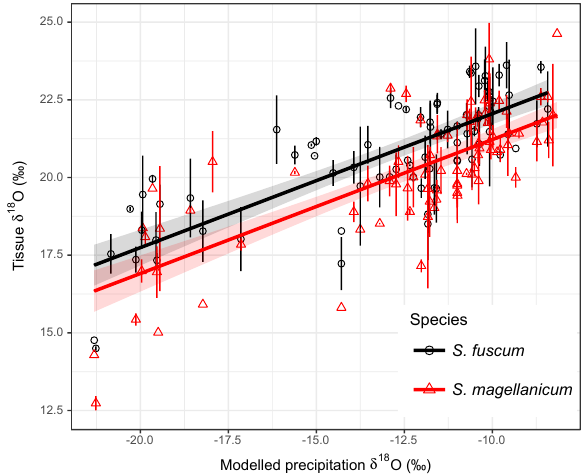
Figure 2. Relationship between height above the water table (HWT, measured at the end of the growing season) and δ 13 C values in two Sphagnum species sampled across the Holarctic realm. Lines show the pooled regression line in a mixed-effect model. Shaded areas indicate approximate 95% confidence intervals (2 × SE) of the regression coefficients that do not include the uncertainty of the random effects. Equations: S. fuscum, δ 13 C =− 27 . 56 − 0 . 021 × HWT; S. magellanicum , δ 13 C =− 27 . 74 − 0 . 045 × HWT. N site = 83, N total = 311. See also Table 1.